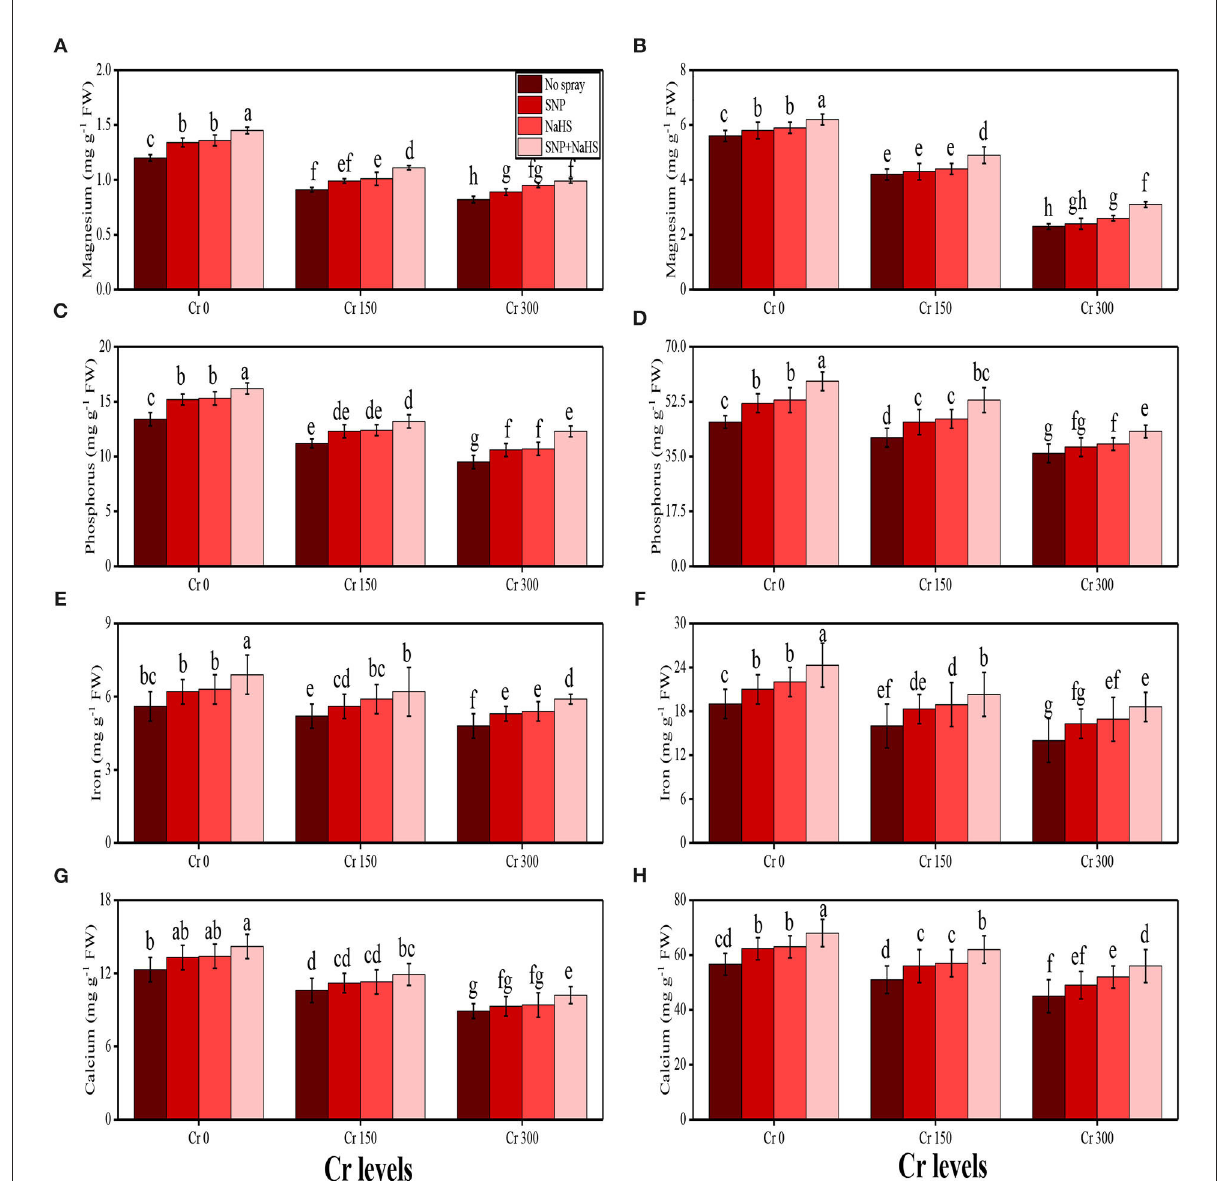
FIGURE5 Impact of individual and combinatorial application of SNP and NaHS on nutritional status, i.e., magnesium content in the roots (A) , magnesium content in the shoots (B) , phosphorus content in the roots (C) , phosphorus content in the shoots (D) , iron content in the roots (E) , iron content in the shoots (F) , calcium content in the roots (G) , and calcium content in the shoots (H) of spinach ( S. oleracea ) plants grown under different levels of Cr [0 (no Cr), 150, and 300 µ M] in sandy loam soil. Values in the figures indicate just one harvest. Mean ± SD ( n = 4). Two-way ANOVA was performed and mean differences were tested by HSD ( P < 0.05). Different lowercase letters on the error bars indicate significant differences between the treatments.